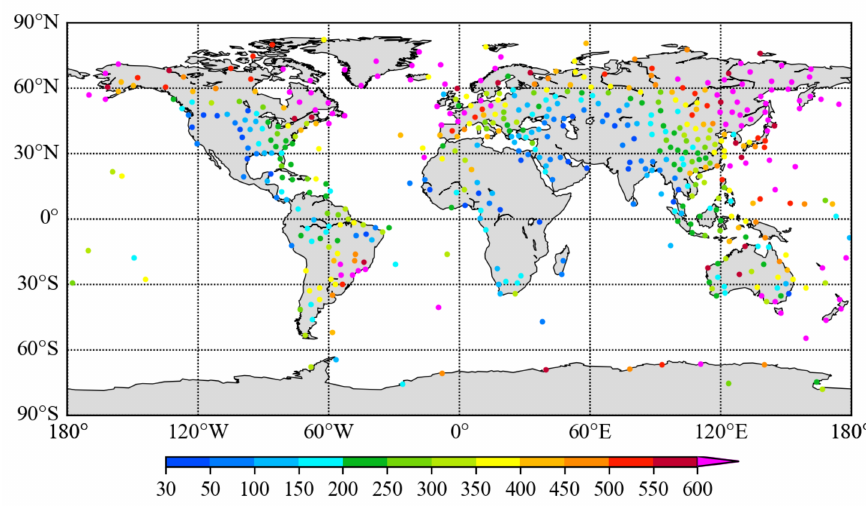
Figure 1. The number distribution of collocated radio occultation (RO) profiles observed by the Global Navigation Satellite System Receiver for Atmospheric Sounding (GRAS) from 1 January 2016 to 31 August